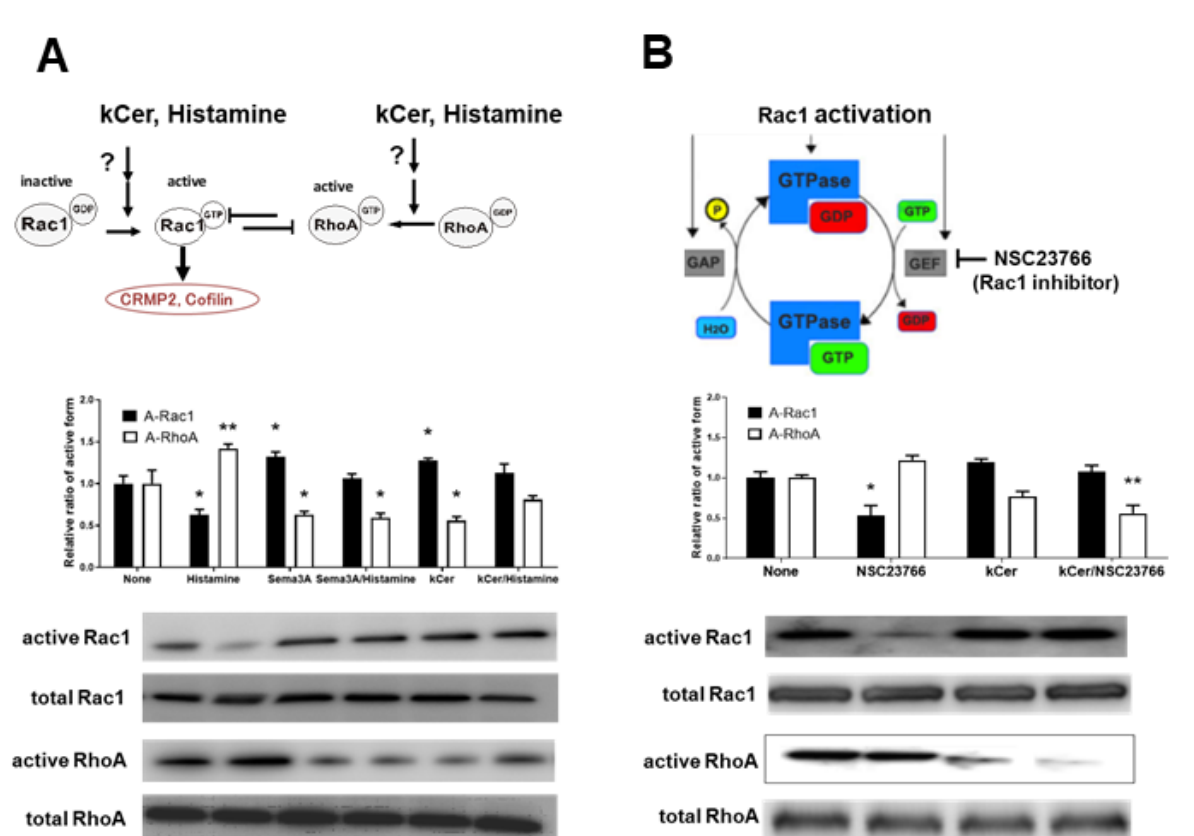
Figure 4. Effects of kCer and histamine on mutual inhibition of the Rac1 and RhoA activation mechanism. ( A ) Two possible working sites of kCer and histamine potentially affect mutual inhibition of Rac1 and RhoA activation, as illustrated in the above chart. In the presence of kCer or histamine, Rac1 and RhoA activation was examined using a G-protein activation assay kit. Western blot band densities were quantified by Image J, and the relative ratio of active/total Rac1(A-Rac1) and active/total RhoA (A-RhoA) are graphed below. Data are presented as the means ± SD ( n = 3). * p < 0.05, ** p < 0.01 vs. no additive (None), one-way ANOVA followed by Tukey’s multiple comparison post-test and Dunnett’s test. ( B ) Illustration of Rac1 activation and the Rac1-specific inhibitor (NSC237669) that prevents GTPase-activation via guanine nucleotide exchange factor (GEF). Active Rac1 is also inactivated by GTPase-activation protein (GAP). Effects of NSC237669 on Rac1 and RhoA activation were examined in the presence or absence of kCer using a G-protein activation assay kit as described above. Data are presented as the means ± SD ( n = 3), followed by statistical analysis as described in ( A